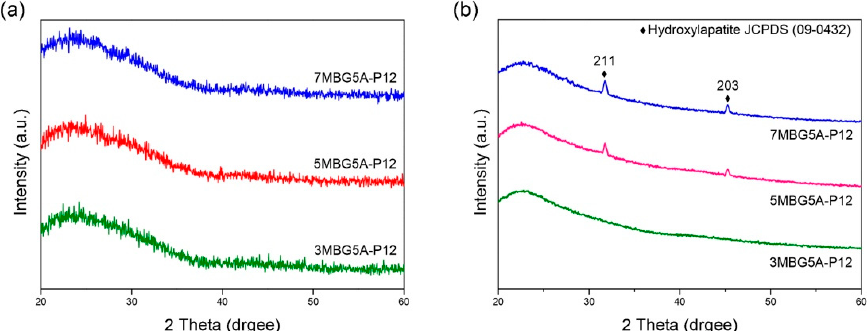
Figure 10. XRD patterns of MBG adding different concentrations of PEG ( a ), and the bioactivity analysis results (XRD patterns) of MBG immersed in SBF for 24 h ( b ).